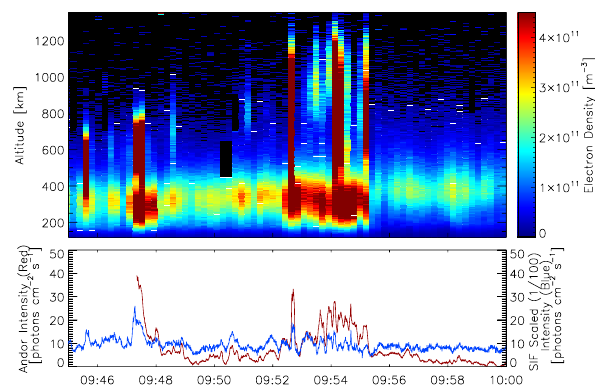
Fig. 4. Data for the interval 09:30–09:45UT. Top panel: ESR raw electron density (scaled Debye-corrected backscattered power) as a function of altitude and time. Bottom panel: Intensity of the optical emission within the solid angle corresponding to the radar beam at 300km altitude for the Andor imager (in red) and the SIF imager (in blue).